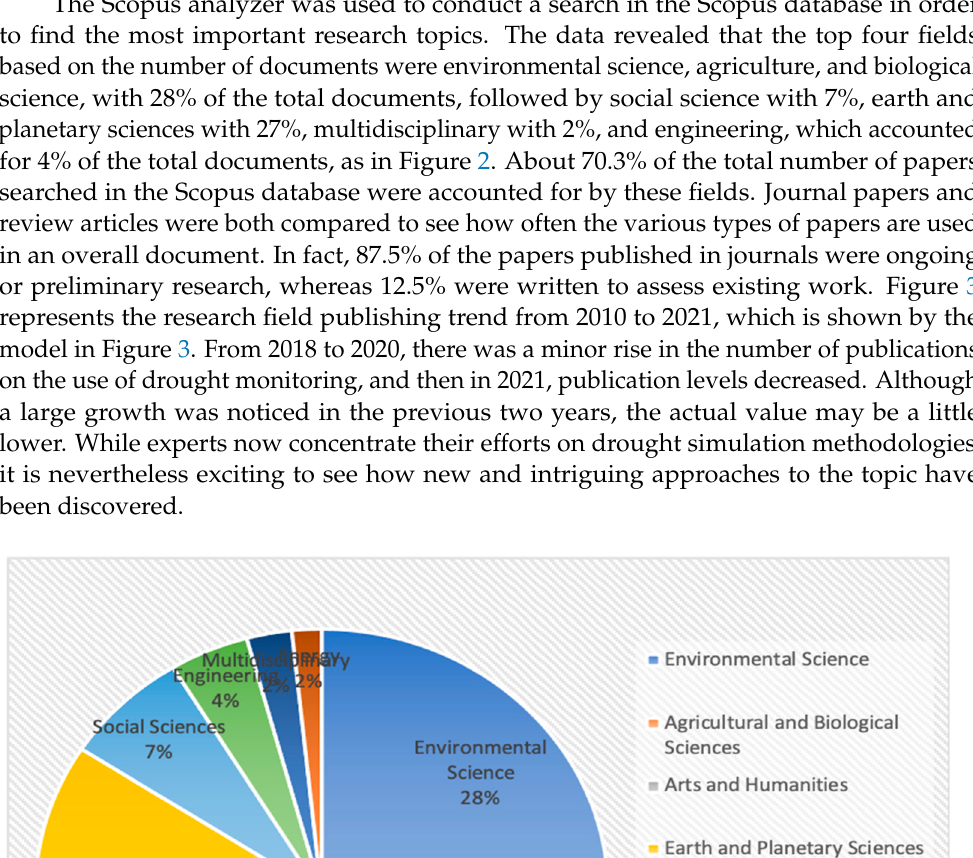
Figure 3. Number of publications for drought analysis per year. 3.2. Keywords Mapping The keywords are an important research resource since they help identify and reflect the topic of study under research. In order to conduct the study, the “type of analysis” was selected as “co-occurrence” and the “unit of analysis” as “all keywords”. To ensure that no term was ever used less than 50 times, the minimum occurrence of a term was set at 50. As indicated in Figure 4b, the density concentration of keywords is marked by dis- tinctive colors Because of these limits, it was determined that only 109 terms from 12,368 fit the criterion. Table 1 shows the top 20 search terms with the highest use in the current investigation that were employed in the research papers in the study. According to the researcher’s analysis, the most regularly appearing terms are drought, climate change,